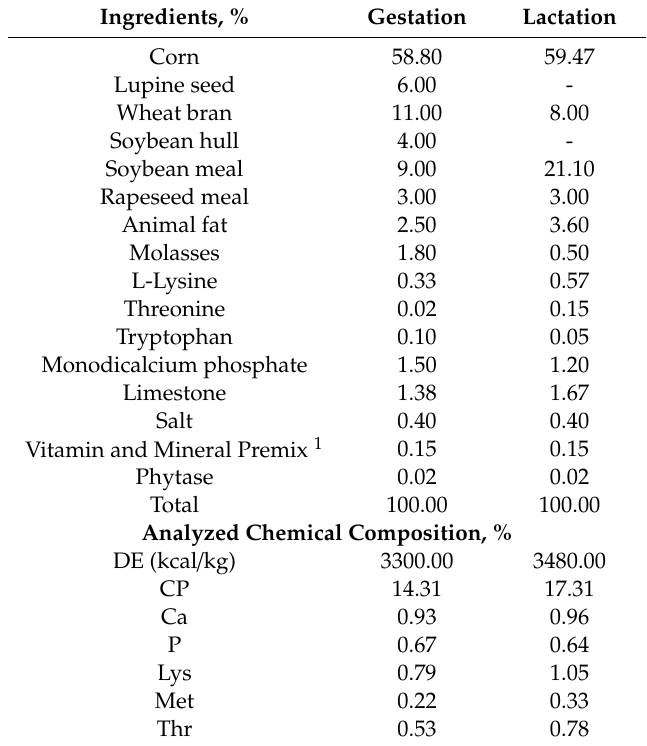
Table 1. Composition of the experimental diets (as-fed, pelleted